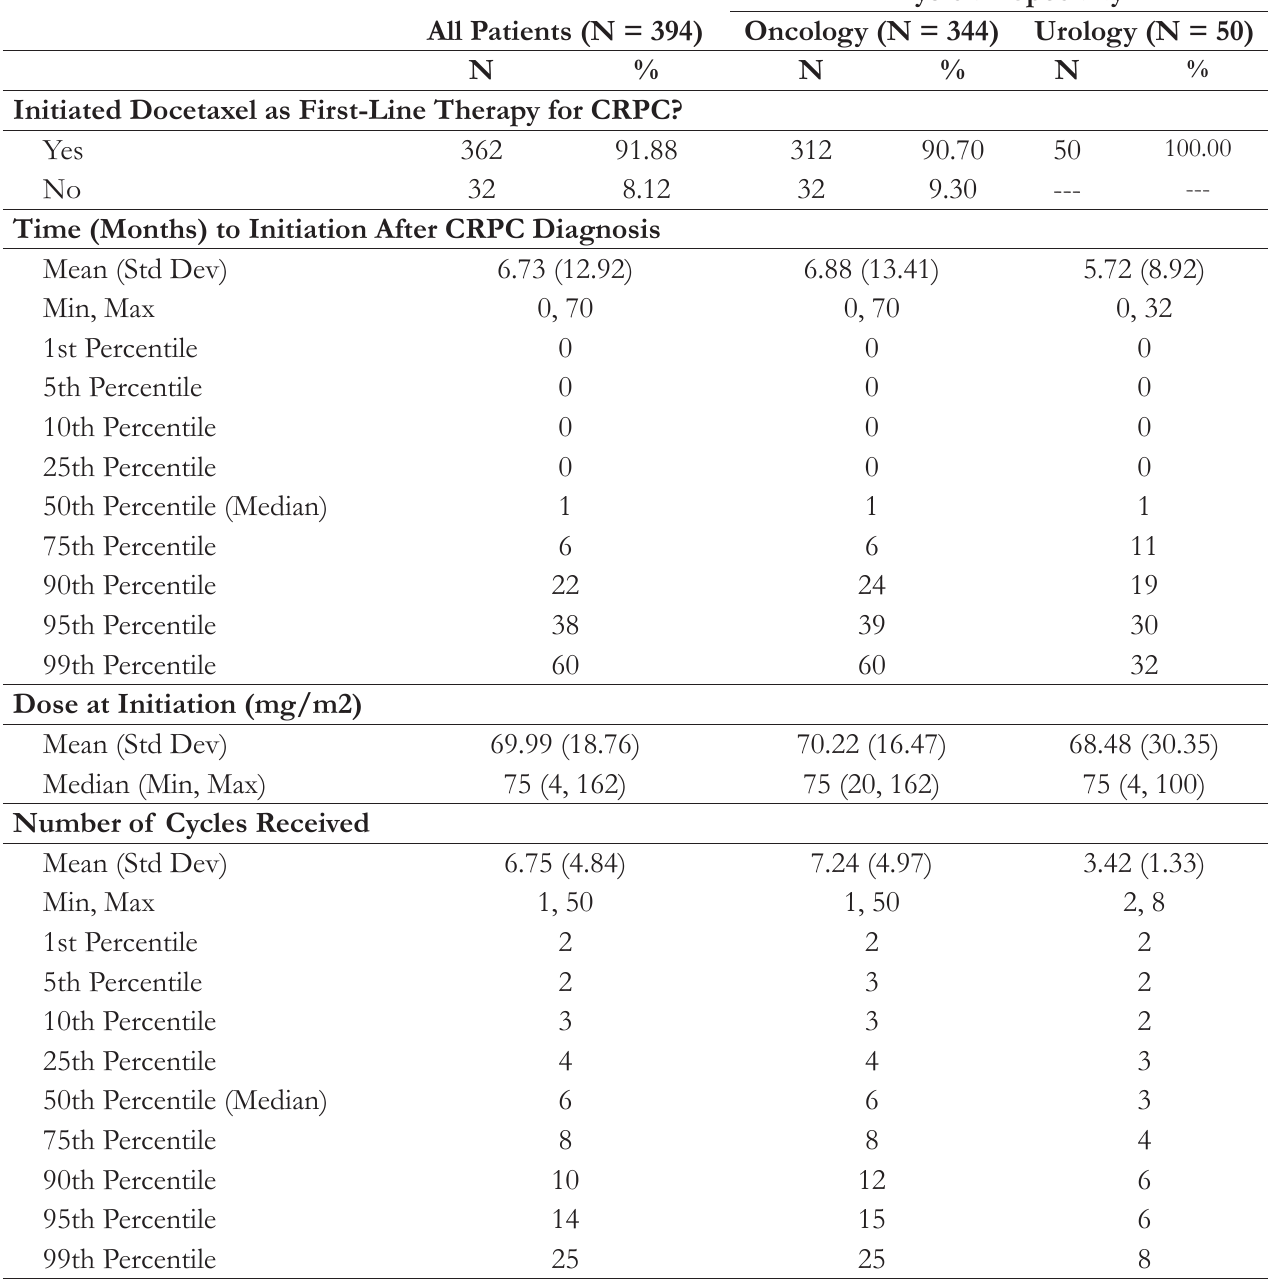
Table 2. Docetaxel Initiation Characteristics, by Specialty of Treating Physician All Patients (N =